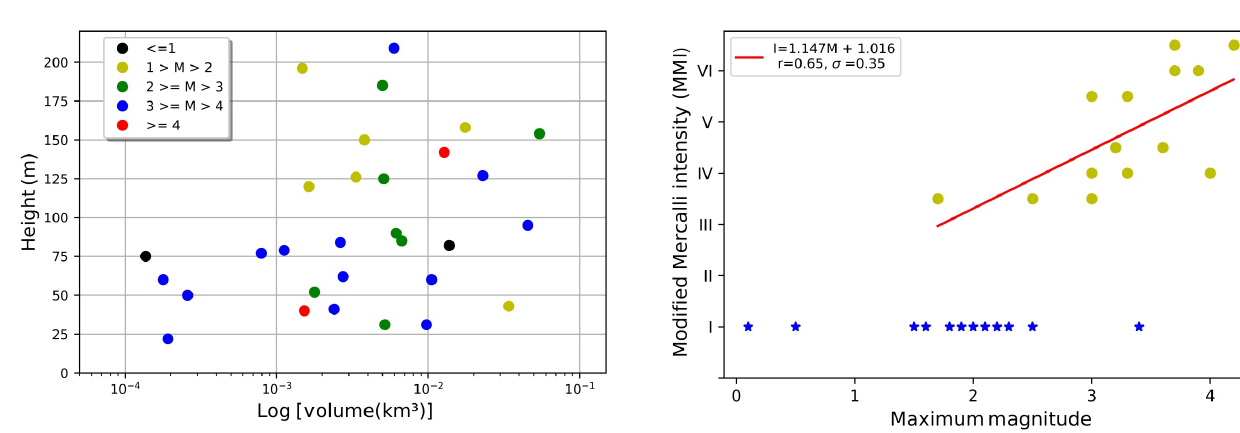
Figure 15. Distribution of reservoir volume and dam height versus the reservoir-triggered seismicity maximum magnitude cases.